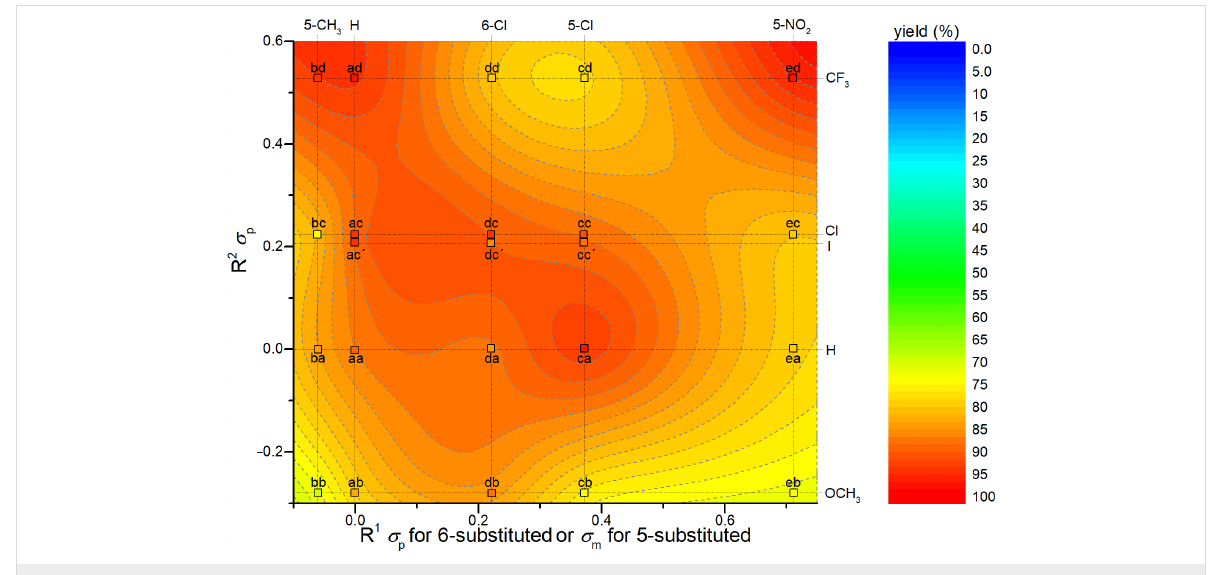
Figure 2: The R 1 and R 2 substitution influence on the isolated yields of products 5aa – ed .